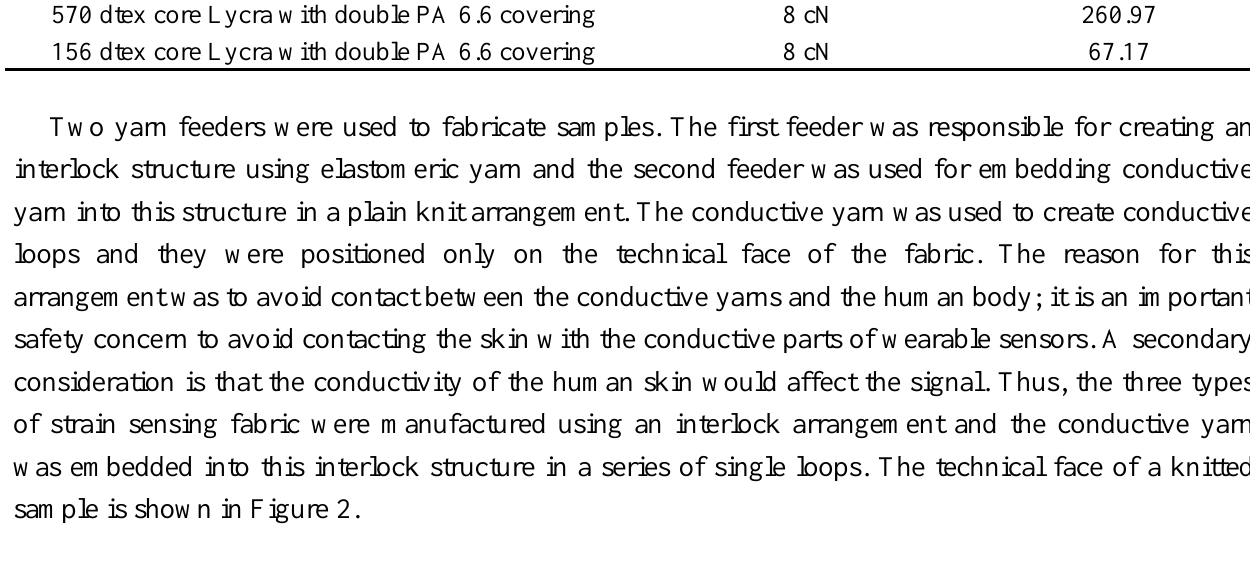
Figure 2. Technical face of sensor design includes conductive & elastomeric